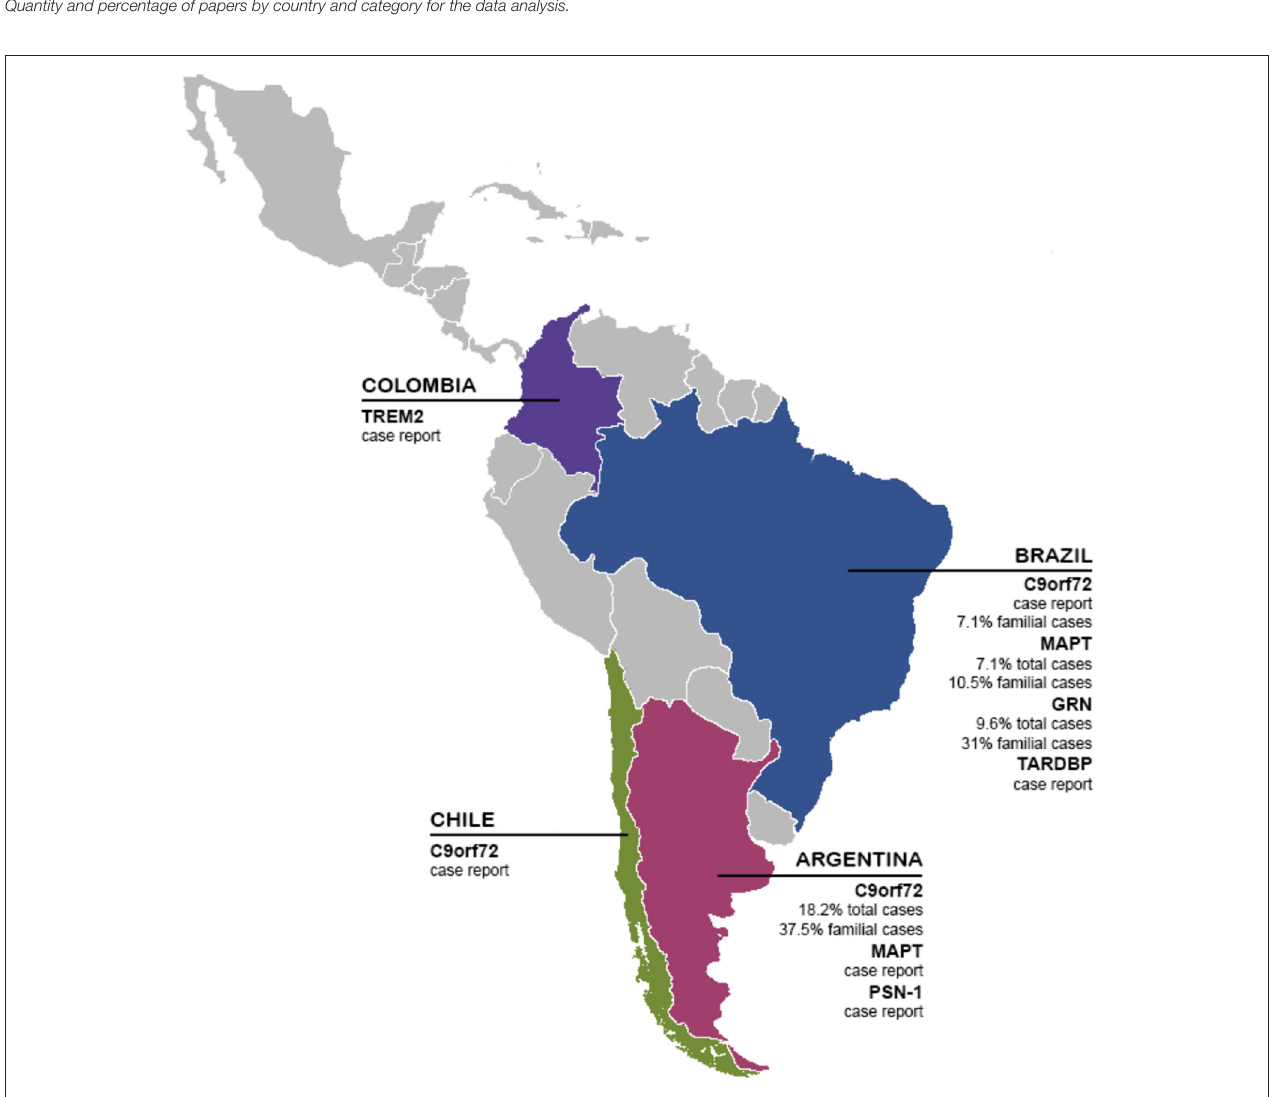
FIGURE 2 | Genetics biomarkers of FTD in LAC. The presence and frequency of FTD genetic biomarkers (TREM2, C9orf72, MAPT, GRN, TARDBP, and PSN-1) in